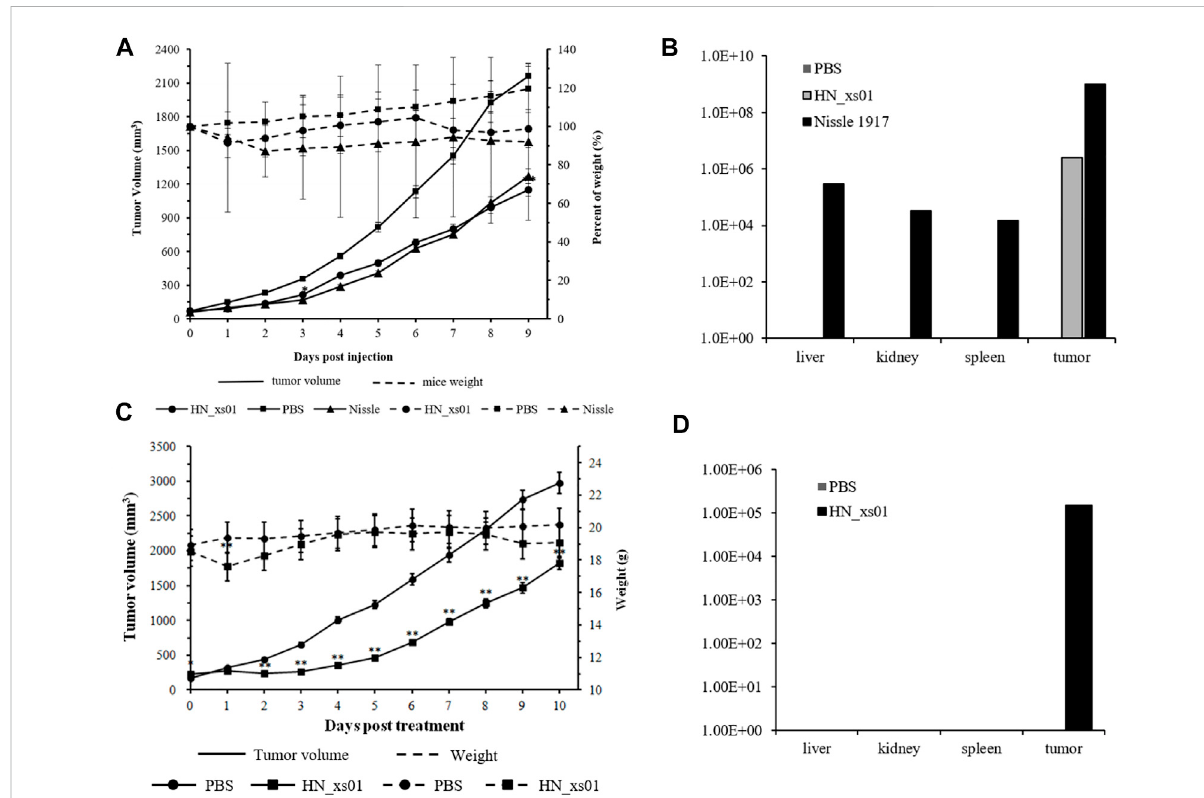
FIGURE 2 The effect and distribution of HN_xs01 on tumor growth and organ colonization following intravenous and intratumoral injections. (A) Mice bearing B16 tumors were injected intravenously with PBS, 2 × 10 6 CFU/100 μ l of E. coli Nissle 1917, or 5 × 10 7 CFU/100 μ l of HN_xs01, respectively. Tumor volume (mm 3 ) and percent of mice weight (%) were measured mice. The antitumor activity of HN_xs01 was similar to that of E. coli Nissle 1917 by intravenous administration. Tumors were signi fi cantly inhibited by intravenous injection of HN_xs01. (B) Bacterial distribution in organs wascalculatedbyCFU/gbyintravenousadministration.StrainHN_xs01wasundetectableintheliver,kidney,andspleen,butsmallamountsof E.coli Nissle1917weredetectedinotherorganscomparedtothetumorarea. (C) MicebearingB16tumorsweretreatedbyintratumoralinjectionofPBSor 1 × 10 8 CFU/100 μ l of HN_xs01. Tumors were signi fi cantly inhibited by intratumoral injection of HN_xs01. (D) Bacterial distribution in organs was calculated by CFU/g via intratumoraladministration.StrainHN_xs01 strictly colonized thetumor region.Data areshown for n =4 miceper group by intravenous injection and n = 7 mice per group for intratumoral